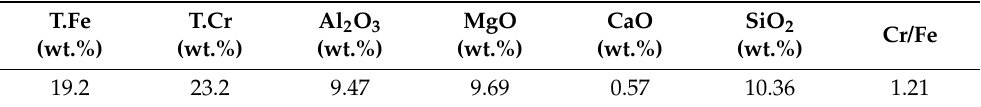
Table 2. Composition of the chromium slag used in the experiment.